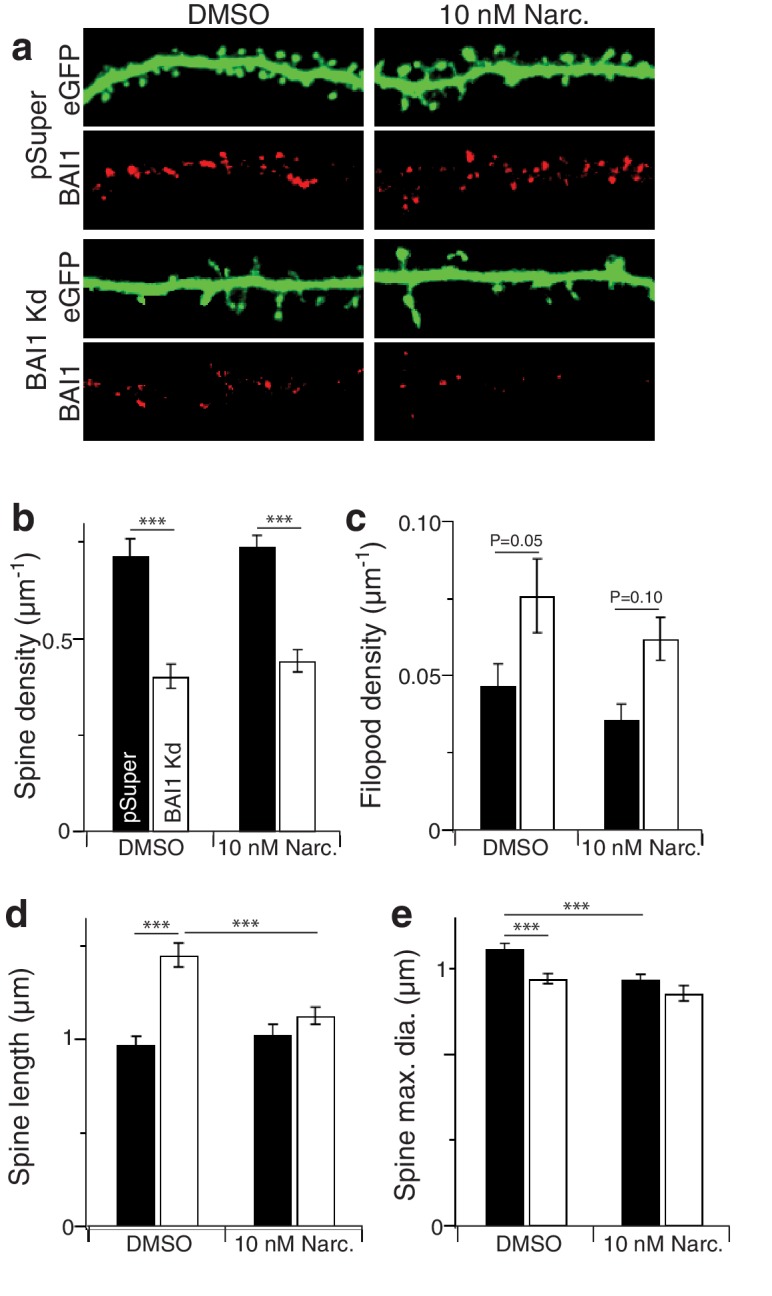
Effect of narciclasine on dendritic spines.(a) Representative segments of secondary dendrites reconstructed from 3D stacks of hippocampal neurons transfected with EGFP and vector (pSuper) or shRNA against Adgrb1 (BAI1 Kd), treated with DMSO or 10 nM narciclasine at 17 DIV, and fixed at 21 DIV. Dendrite morphology is shown by EGFP (green), and neurons were also stained for BAI1 (red). (b) Summary data for spine density. (c) Summary data for filopod density. (d) Summary data for spine length. (e) Summary data for spine maximum diameter. Total number of neurons 30 for each condition (N = 3). Data are represented ± s.e.m. (***p<0.0001, **p<0.01, *p<0.05) Detailed statistics are found in Figure 4—figure supplement 2—source data 1.10.7554/eLife.47566.033Figure 4—figure supplement 2—source data 1.Statistical summary for Figure 4—figure supplement 2: ANOVA and key Tukey post-hoc tests and N and n values for Figure 4—figure supplement 2b–e.